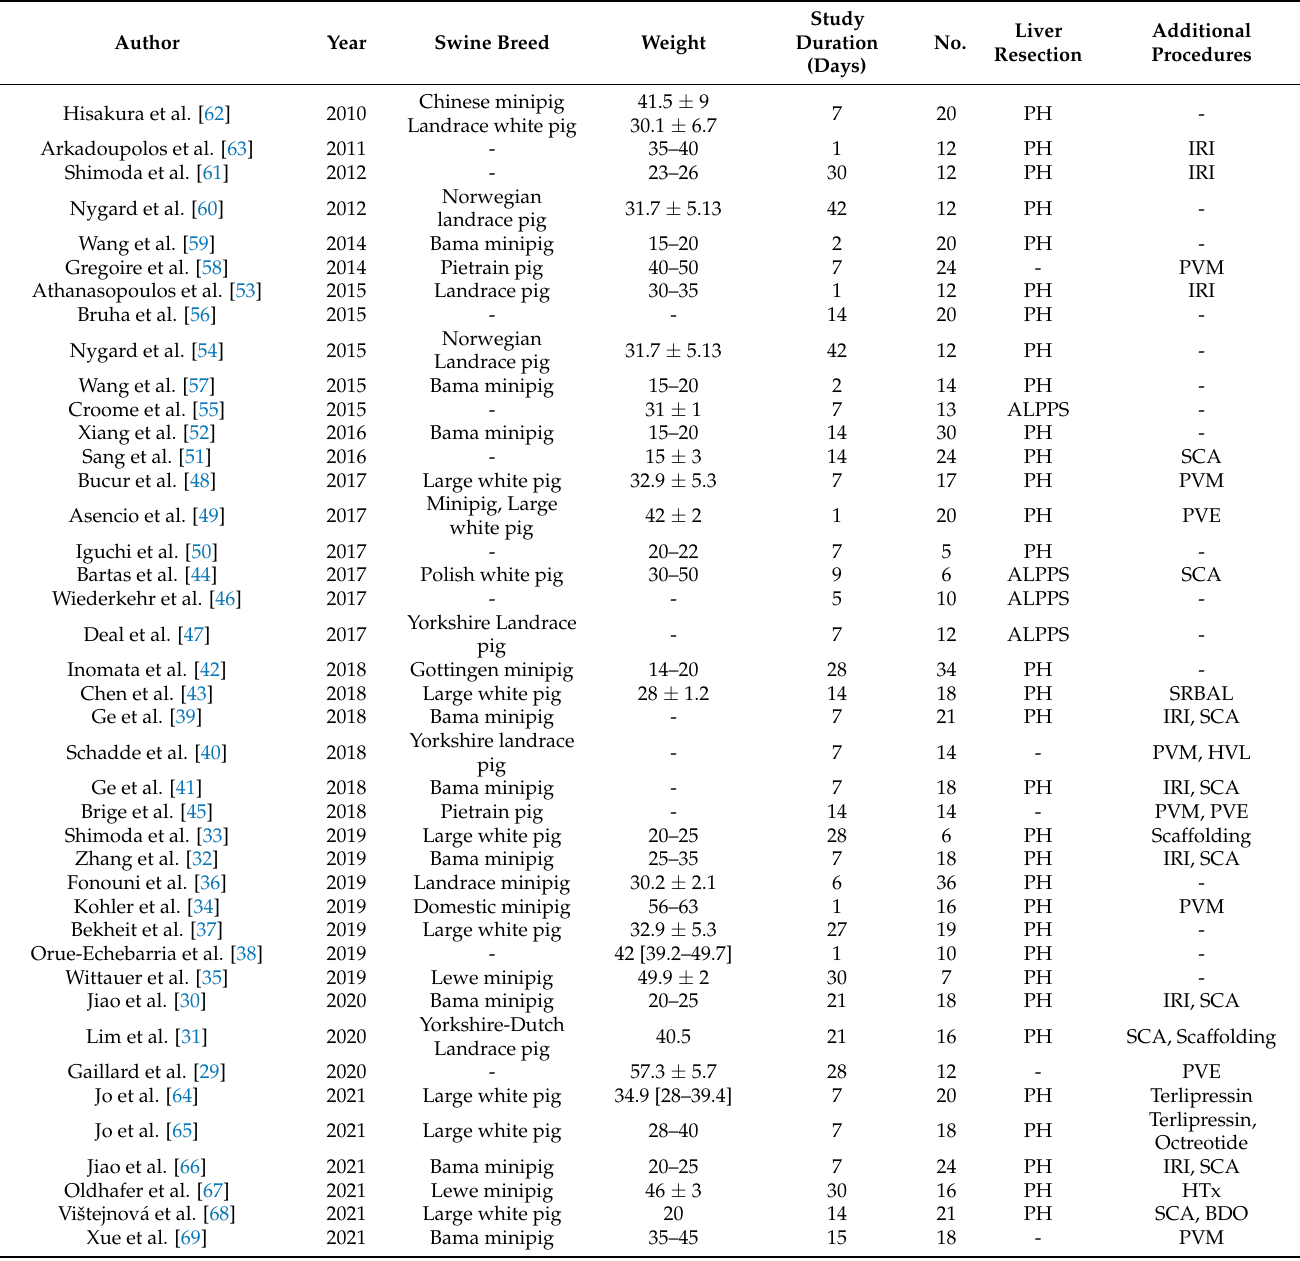
Table 1. General information about selected